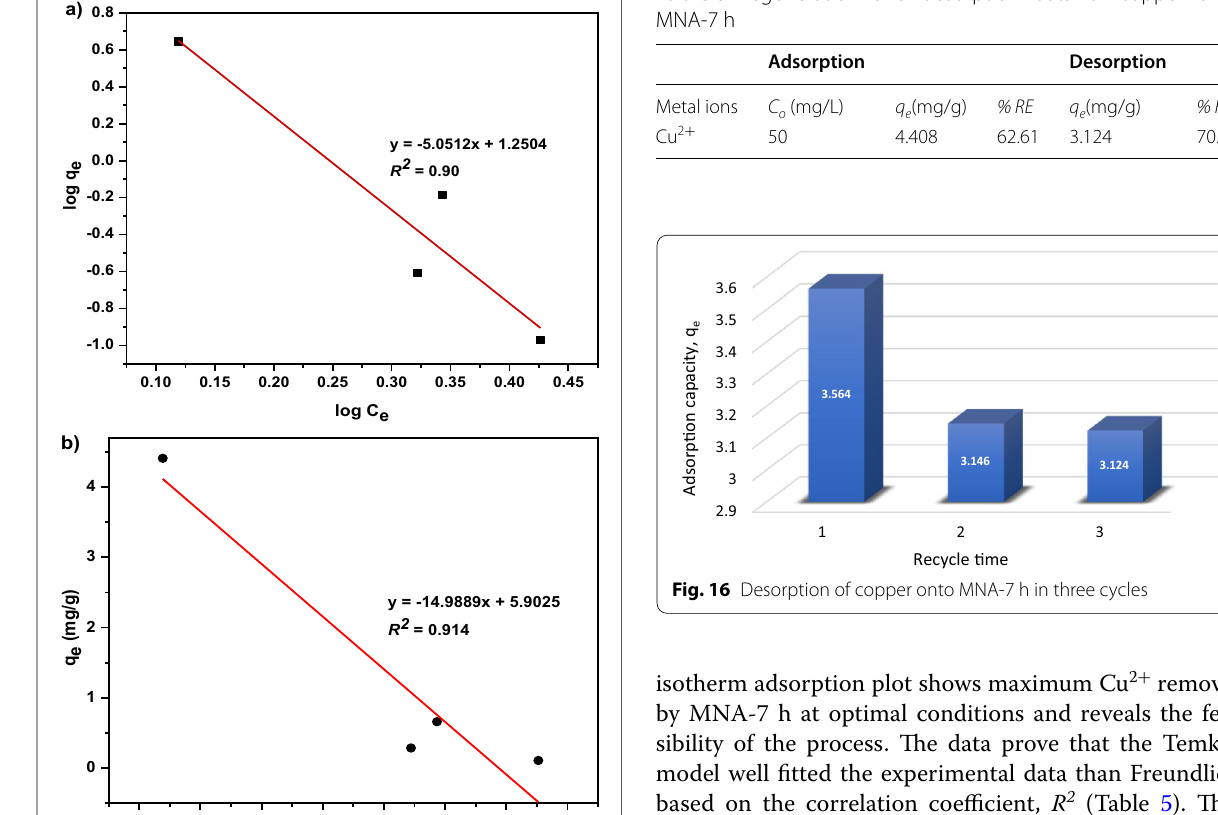
Table 5 Freundlich, Temkin parameter with correlation coefficient, R 2 for adsorption of Cu (II) on MNA-7 h at room temperature Isotherm model Parameter Values Freundlich isotherm model K F 3.4917 Temkin isotherm model